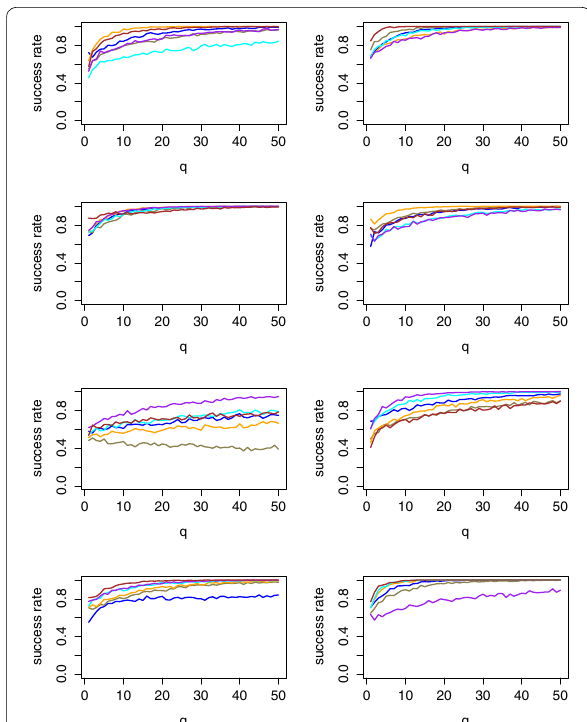
Fig. 8 Success rates per tag value for Users 1, 3, 5 and 7 (left column) and Users 2, 4, 6 and 8 (right